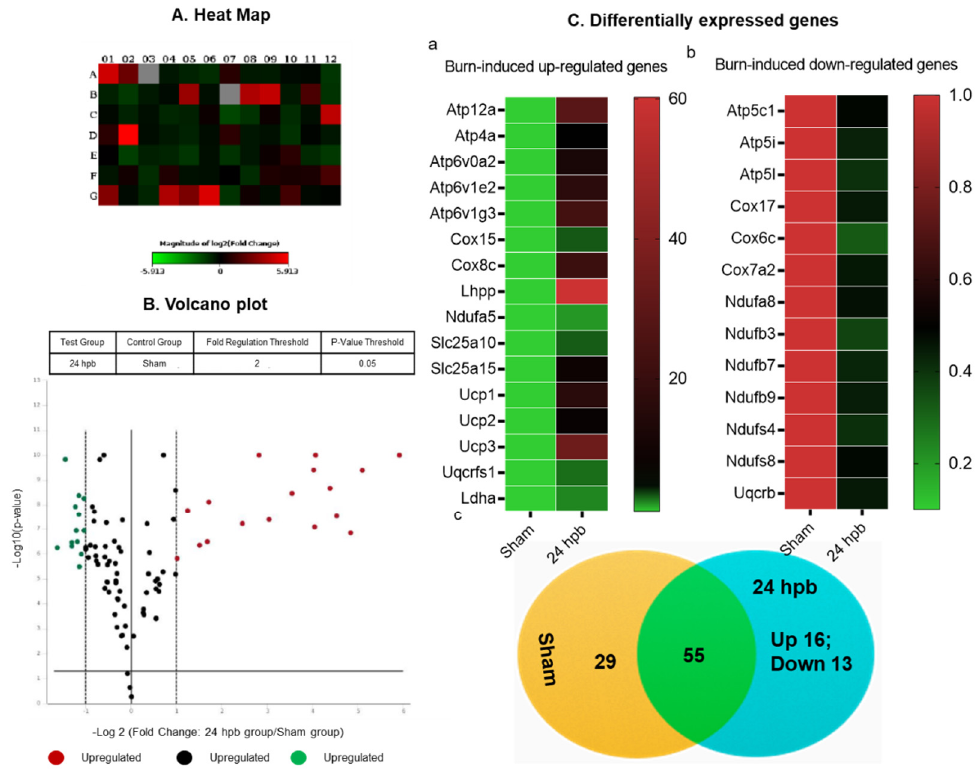
Figure 4. The analysis of burn-induced cardiac metabolism-related gene expression; ( A ) original heat map demonstrates upregulated genes in red and downregulated genes in green; ( B ) volcano plot demonstrates significant gene expression vs. fold change on the y and x axes, respectively. Red represents the upregulated genes, green represents downregulated genes and black represents no significant change; ( C ) shows upregulated genes ( a ), downregulated genes ( b ), and summary ( c ) after burn.